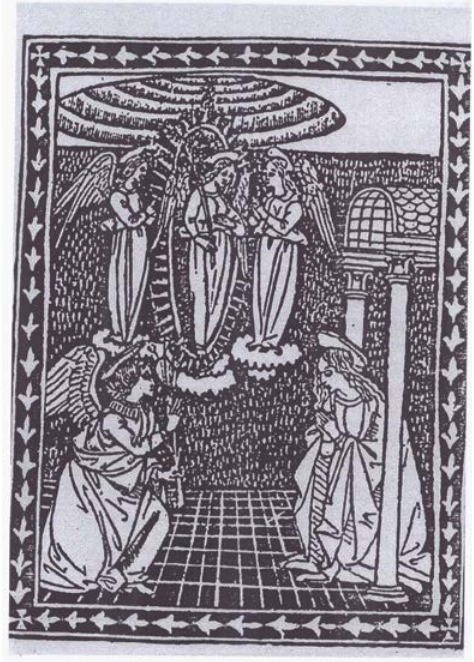
Figure 31 – Rappresentazione dell’Annunciazione , fece stampare Maestro Francesco di Giovanni Benvenuto, s.l.a. [but Firenze around 1495], f. a1r (BNCF, Pal. E.6 7.53.16). By permission of Ministero per i beni e le attività culturali / Biblioteca Nazionale Centrale. Firenze